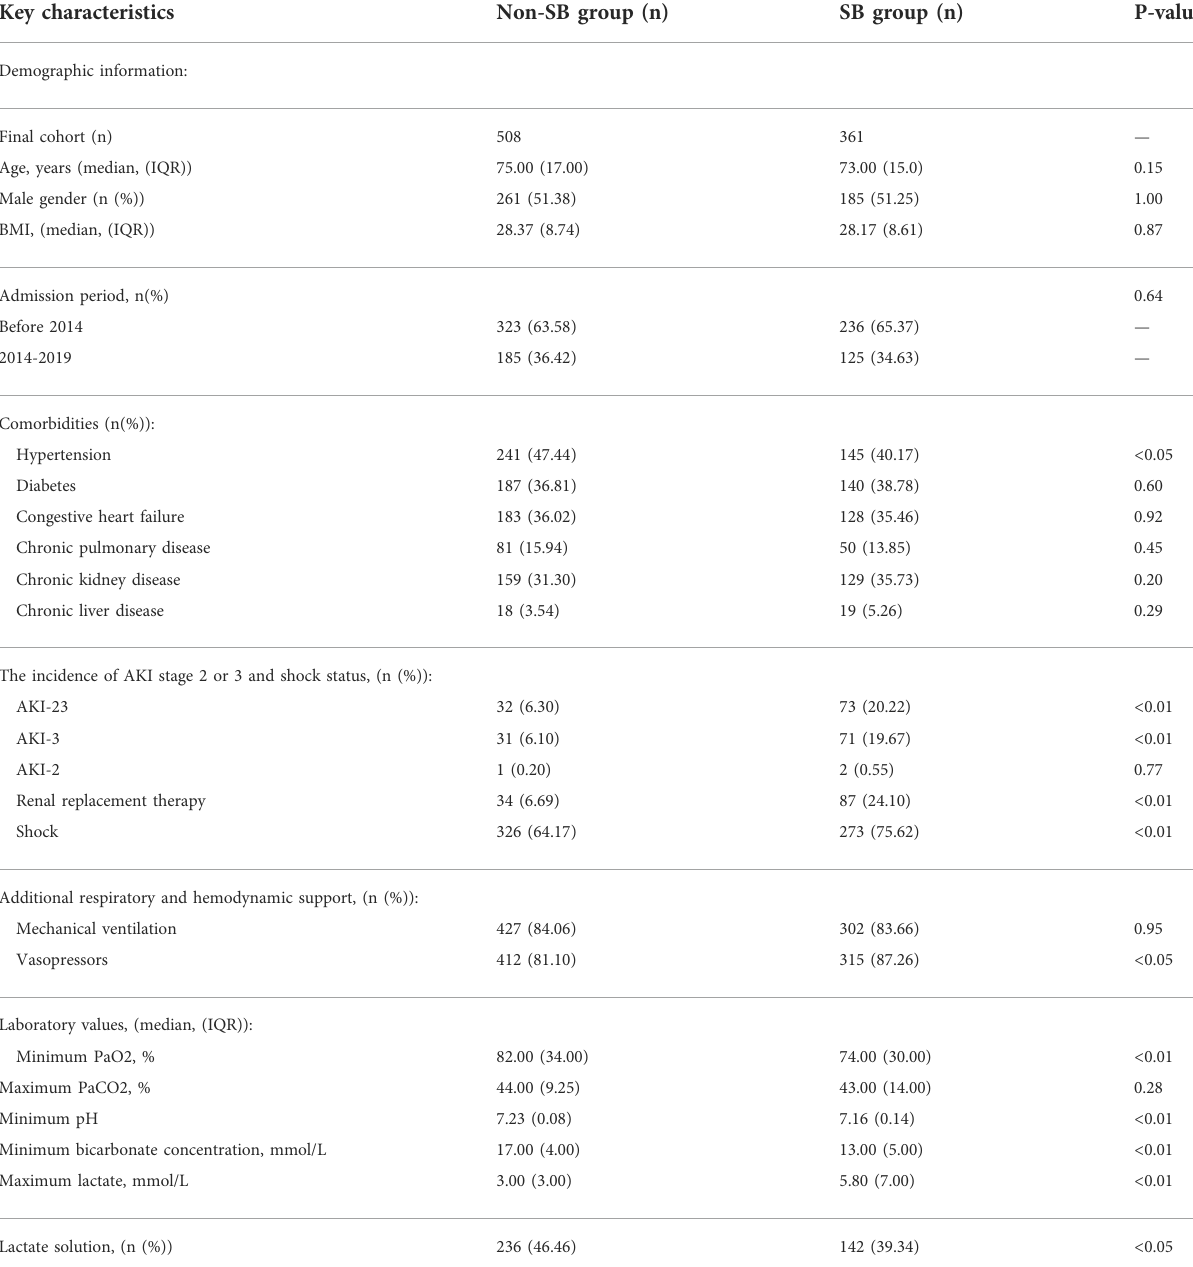
TABLE 1 Baseline differences between two groups before propensity score matching.